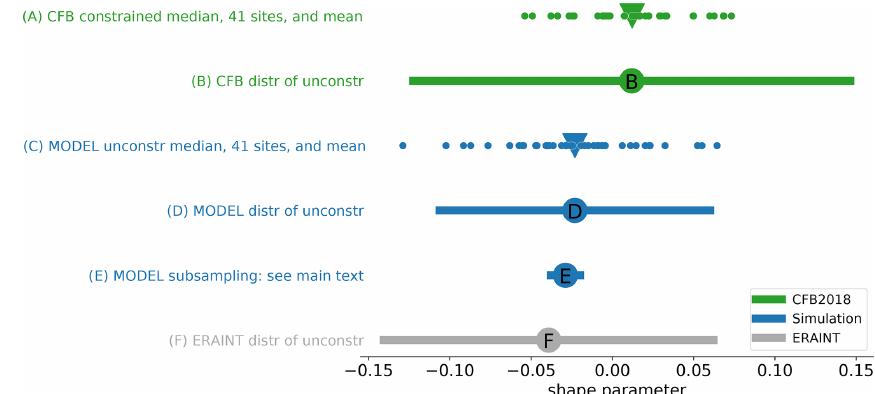
Figure 3. Further results related to the model vs. CFB2018 shape parameter difference. Each line shows ( X axis; dimensionless) a distribution of GPD shape parameters, or a derived quantity such as the mean of several shape parameters. “unconstr”: unconstrained. For full details see the main